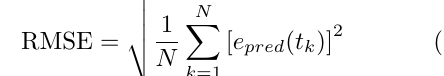
Figure 8: Upper plot: Real (measured) and simu- lated T reac , and time intervals for estimation (marked ’o’). Middle plot: Real P heat . Lower plot: T room = T feed